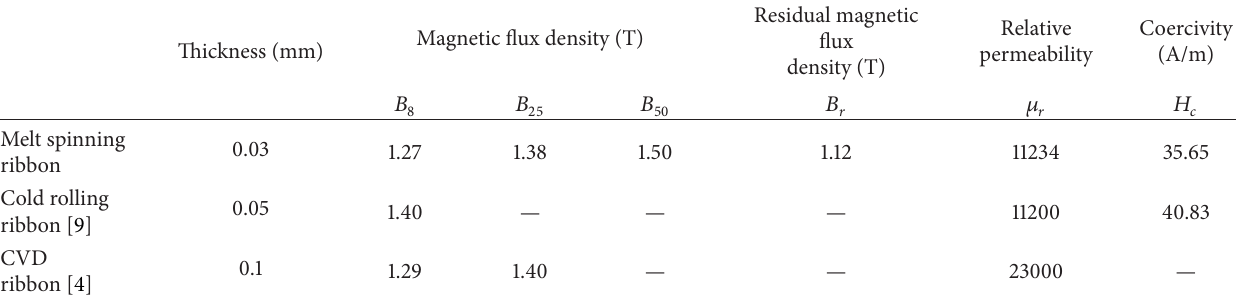
Table 2: DC magnetic properties of ribbons produced by melt spinning.